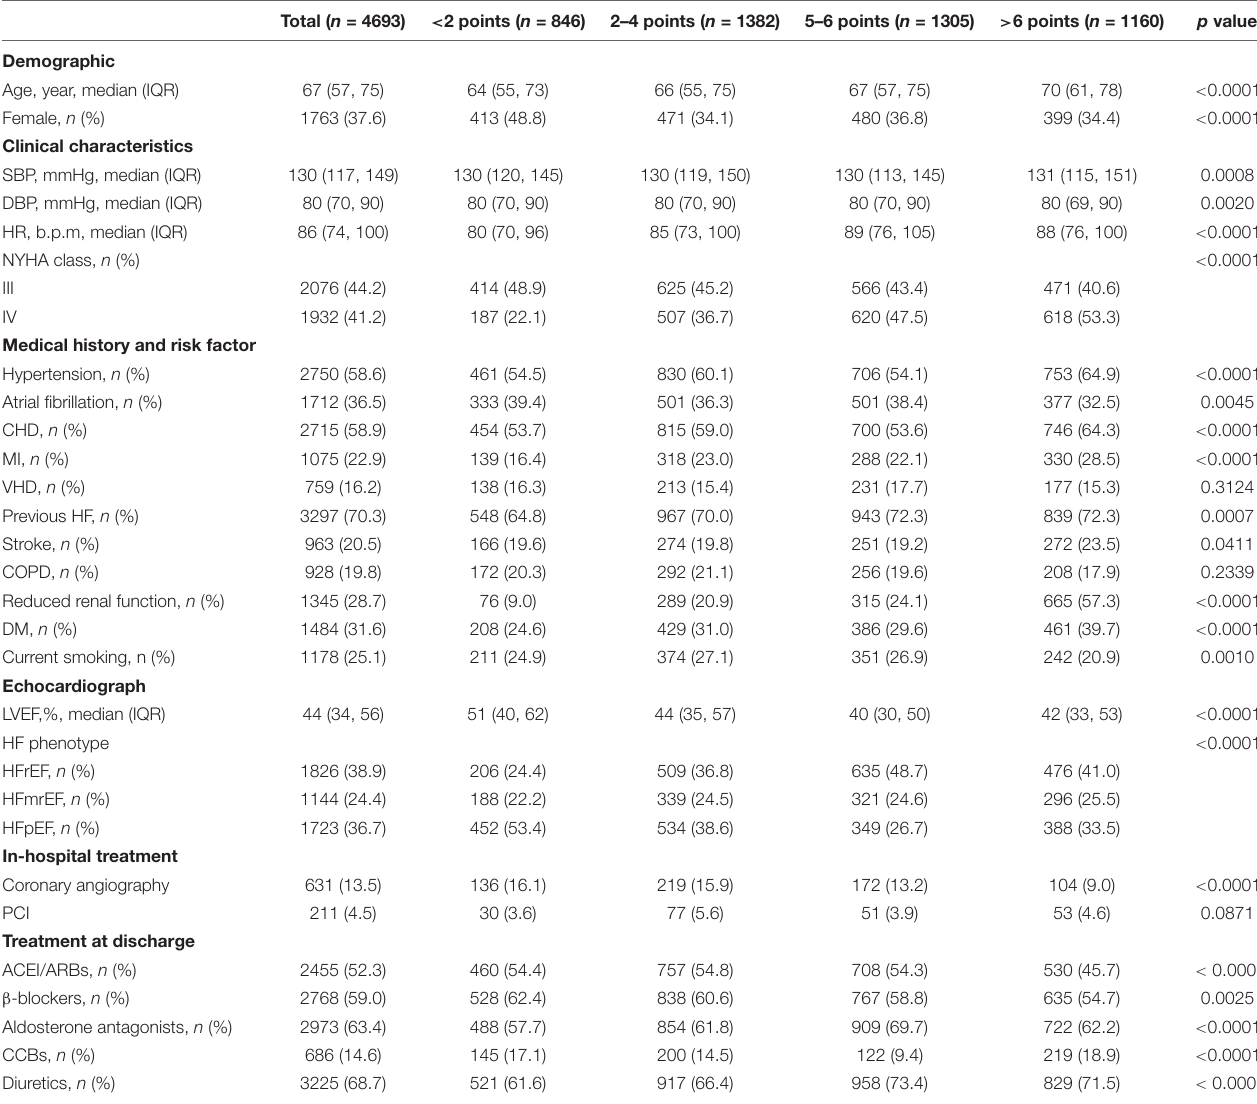
TABLE 1 | Baseline characteristics by multi-biomarker point groups in overall